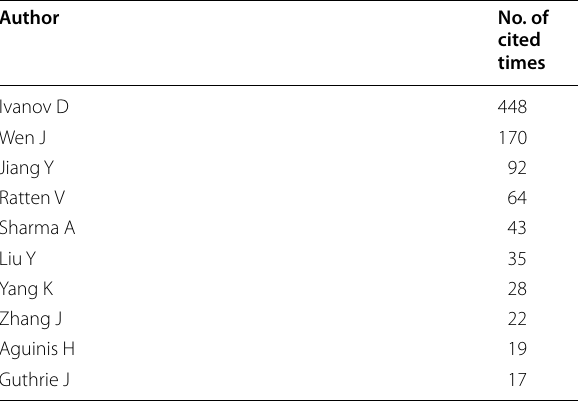
Table 8 Top 10 cited authors of Covid‑19 and